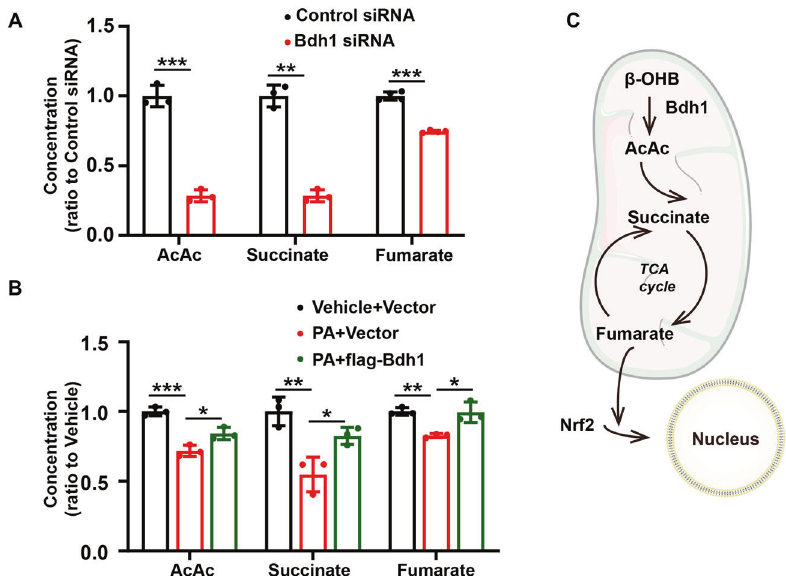
Fig. 6 Bdh1-mediated β OHB metabolism promoted the fumarate production through AcAc-succinate-fumarate metabolic pathway. A The concentrations of AcAc, succinate, and fumarate in LO2 cells transfected with control siRNA or Bdh1 siRNA. B The concentrations of AcAc, succinate, and fumarate in vector or Bdh1-overexpressed LO2 cells stimulated by vehicle or PA (D). C Scheme showing the Bdh1- regulated metabolic fl ux composed of β OHB-AcAc-succinate-fumarate. All results are representative of three independent experiments. Values are presented as mean ± SD. * P < 0.05; ** P < 0.01; *** P <